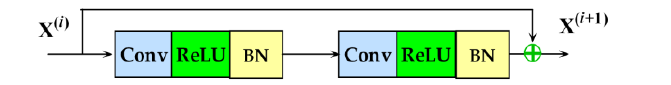
Figure 2. A residual unit (two convolutional layers, each following an activation layer and a batch normalization layer).